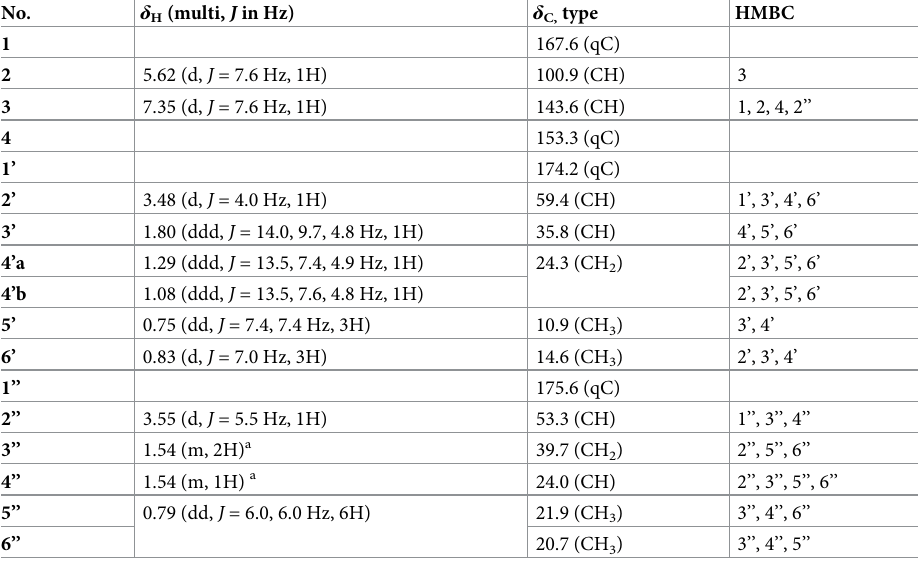
Table 1. 1 H and 13 C NMR spectral data for petromyzonacil